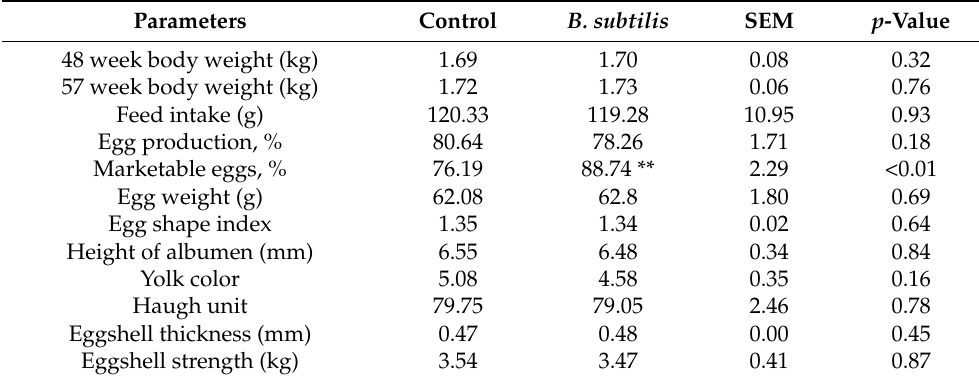
Table 4. Effects of Bacillus subtilis on egg production and egg qualities of laying hens from 48 to 57 weeks of